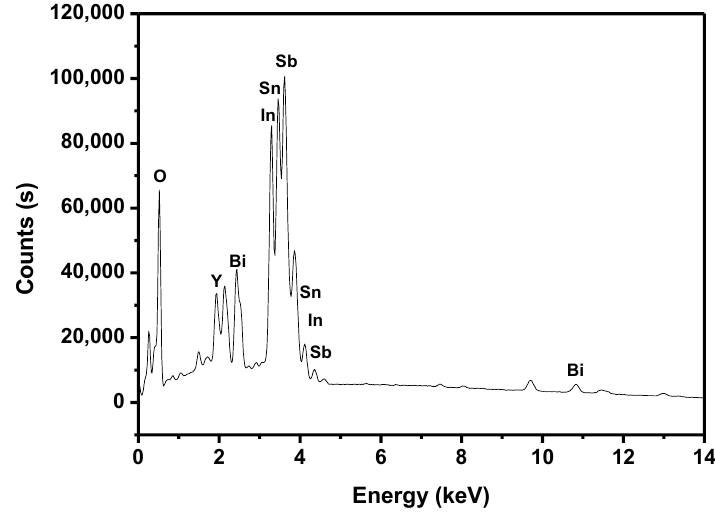
Figure 14. EDS spectrum of IBHP.